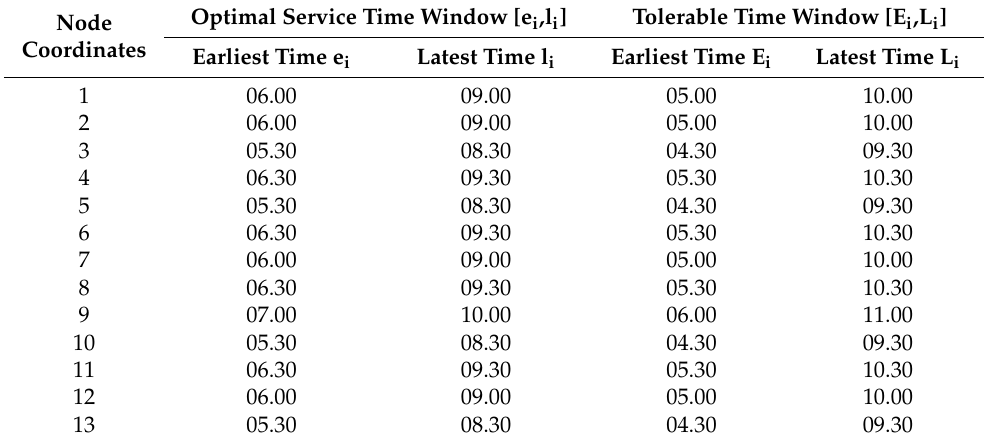
Table 6. Customer best service time window and tolerable time window statistics